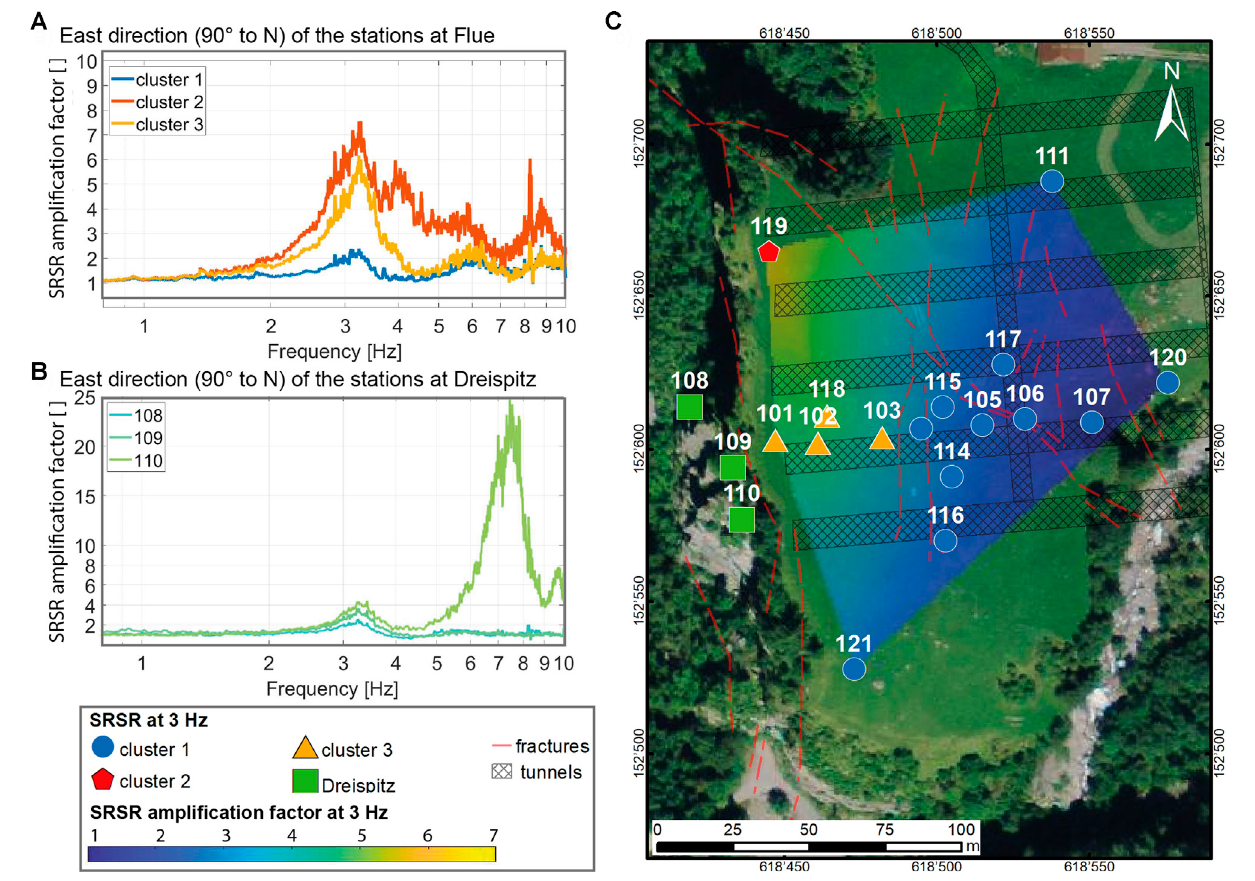
FIGURE 5 | Site-to-reference spectral ratios (SRSR) of ambient vibration data recorded at the site Mitholz in 2019; (A) SRSR mean curves for cluster 1-3 in the direction of maximum ampli fi cation (east-component); (B) SRSR curve in east-direction of the stations located at Dreispitz (108 – 110), representing the cluster Dreispitz; (C) location map of the stations with the assignment to the different clusters, the current tunnel system around 100 m underneath (black crossed lines) and the known fractures from the tunnel excavation in 1941. Additionally, the SRSR map of the east-component, which is the direction of main polarization, for the fundamental frequency of 3 Hz with respect to reference station 120 is displayed; the color represents the ampli fi cation factor as indicated in the legend.